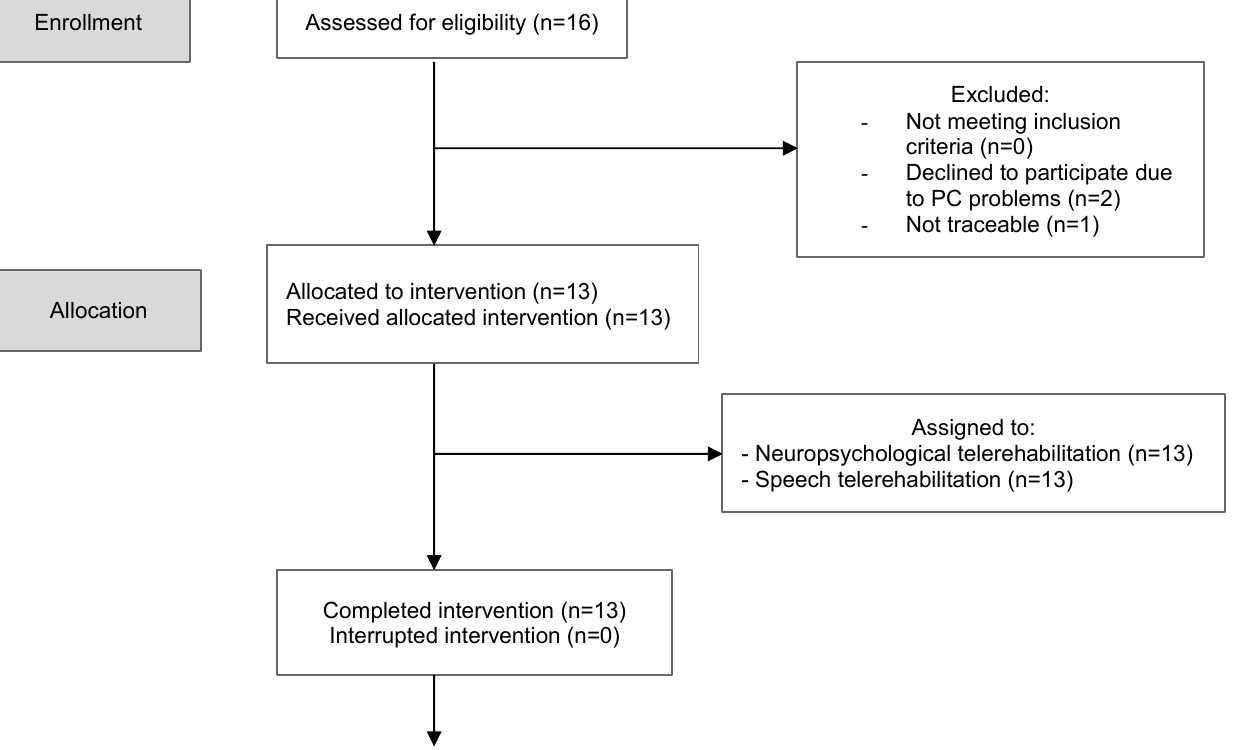
Allocated to intervention